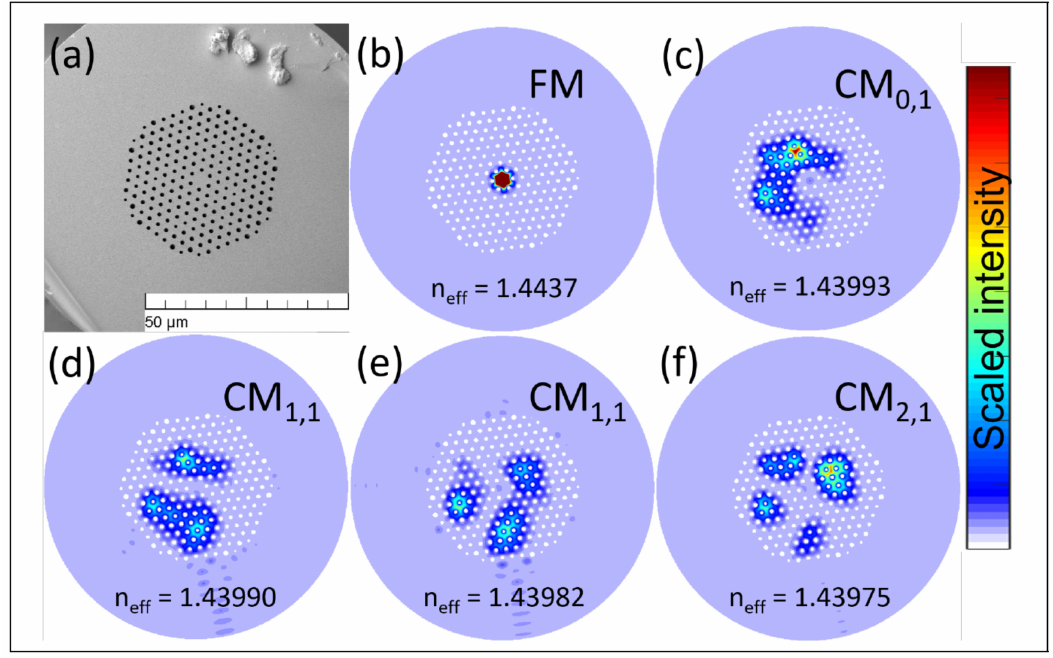
Figure 3. ( a ) Scanning electron microscope image of the endlessly single-mode fiber (ESF). The simulated ( λ = 1060 nm) modes of the ESF are as follows: ( b ) single core-guided mode and ( c–f ) a few higher-order cladding modes (CM), with the first subscript being the angular quantum number and the second subscript being the radial. The e ff ective index of refraction n e ff is shown for each